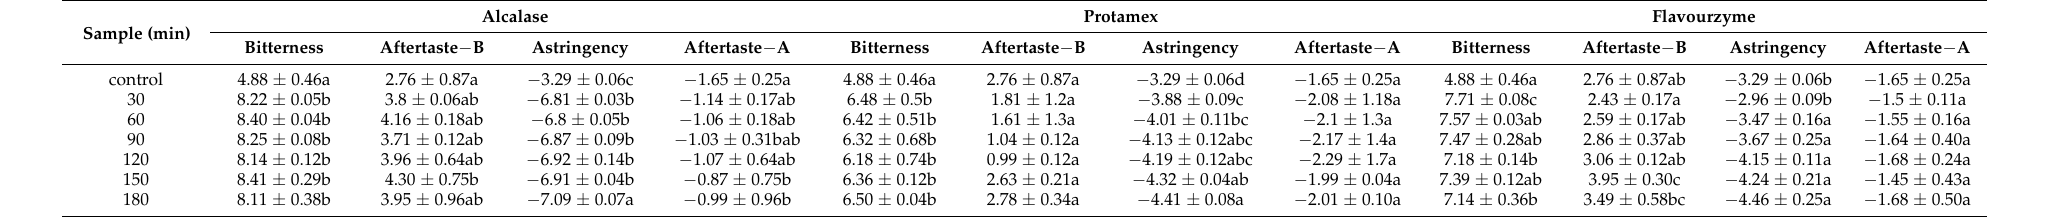
Table 3. The sensor outputs of MPC hydrolysates obtained by the electronic